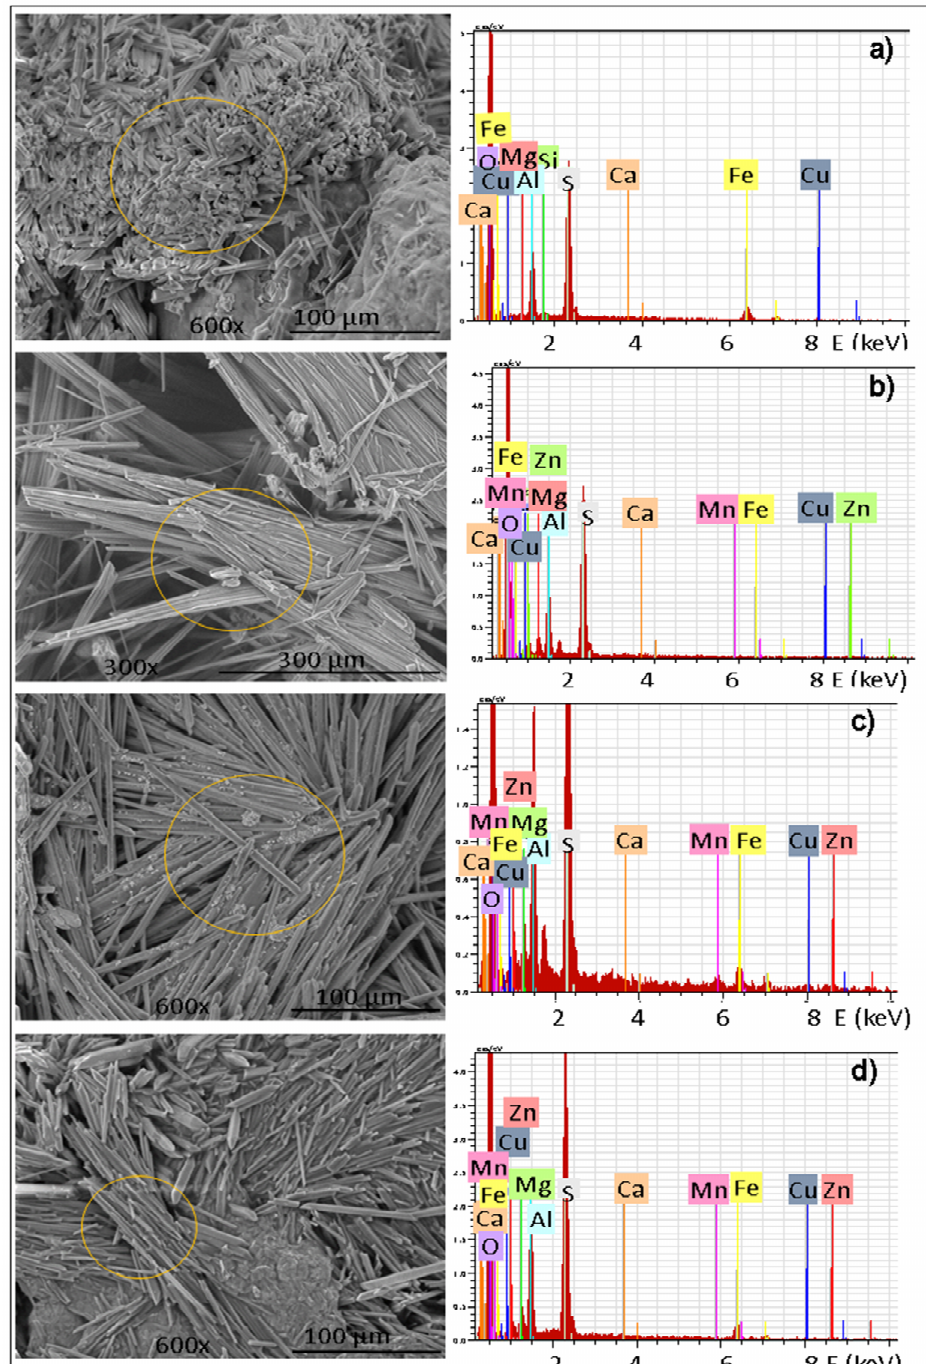
(Figure 10) corroborates the results achieved previously.